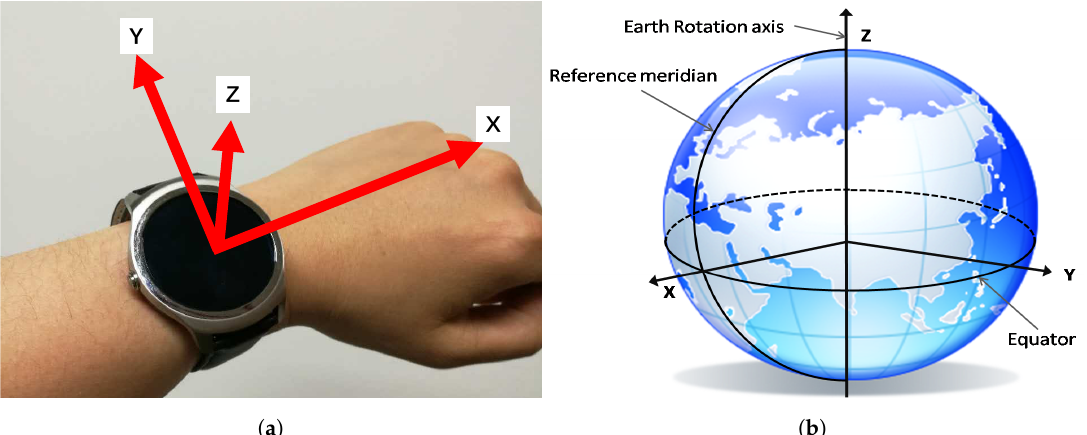
Figure 3. Coordinates transformation: ( a ) Device coordinates; ( b ) Earth